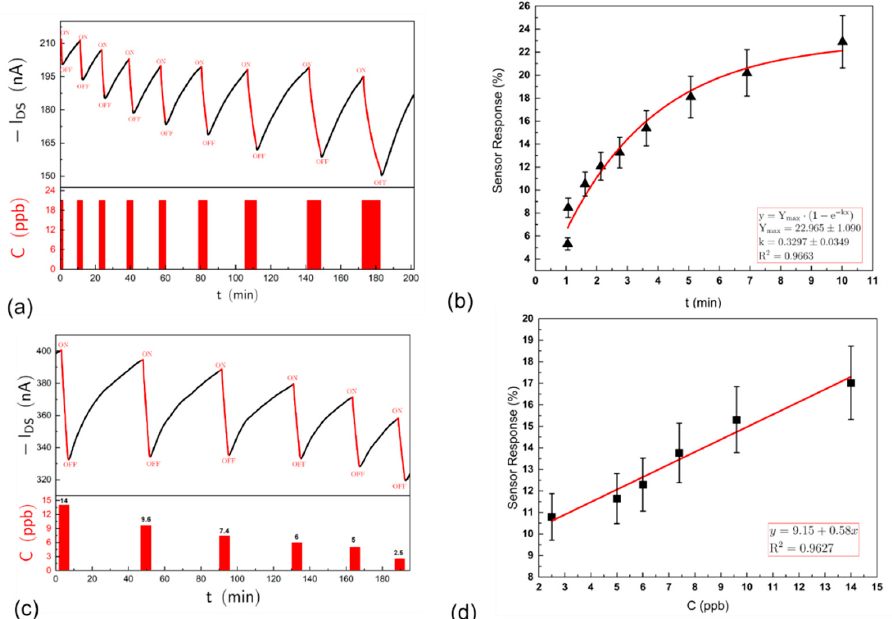
Figure 4. ( a ) Exposure of an OFET sensor to 21 ppb ammonia for increasing lengths of time, followed by recovery in clean air. Red bars in the lower panel indicate the period of exposure. The sensor response increases with the length of exposure; ( b ) the kinetics of the response to a fixed concentration of ammonia over time. The response approaches a steady state after about 10 min but has not yet reached an asymptope; ( c ) the top panel—another OFET sensor was exposed to pulses of ammonia at different concentration steps for periods of 5 min followed by recovery in clean air for 30 min. The change in I DS current was measured at each step. Bottom panel—concentration steps in ppb presented to the sensor; ( d ) concentration–response curve for ammonia at low concentrations from repeated experiments shown in ( c )—this can be fitted by a linear equation. Table 1. Molecular parameters, Antoine parameters, measured sensitivity, limit of detection (LOD) and predicted sensitivity.